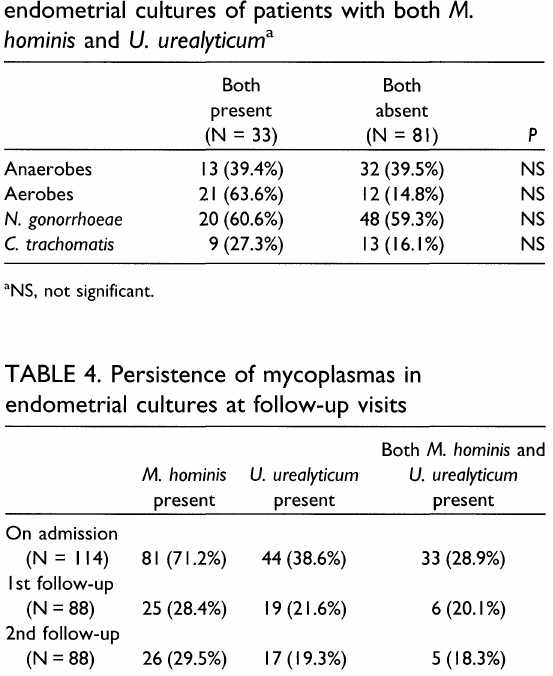
TABLE 4. Persistence of mycoplasmas in endometrial cultures at follow-up visits